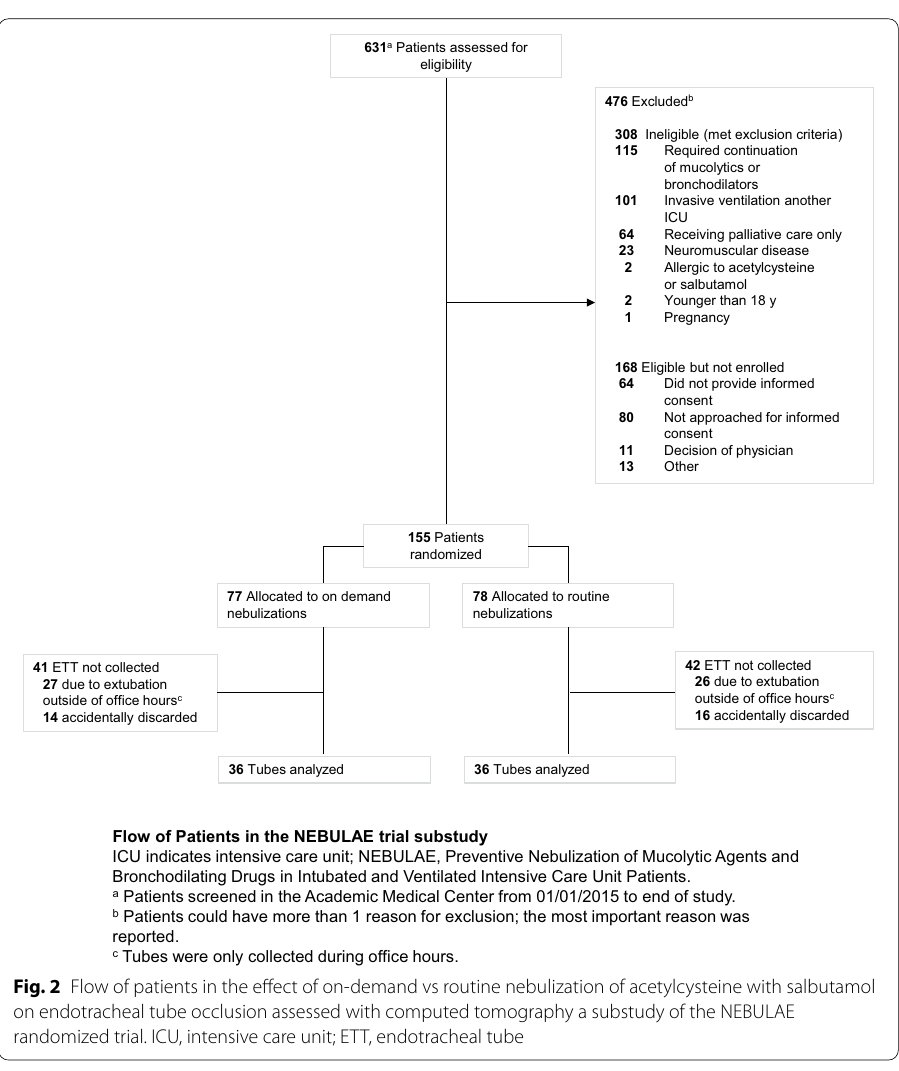
Fig. 2 Flow of patients in the effect of on-demand vs routine nebulization of acetylcysteine with salbutamol on endotracheal tube occlusion assessed with computed tomography a substudy of the NEBULAE randomized trial. ICU, intensive care unit; ETT, endotracheal